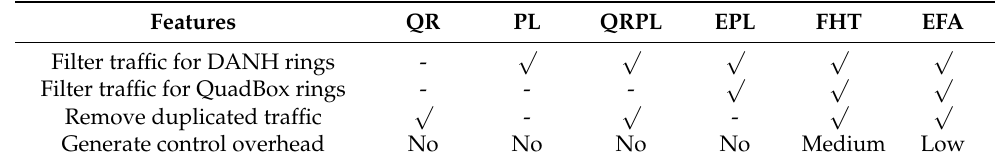
Table 2. A comparison of features of traffic filtering-based